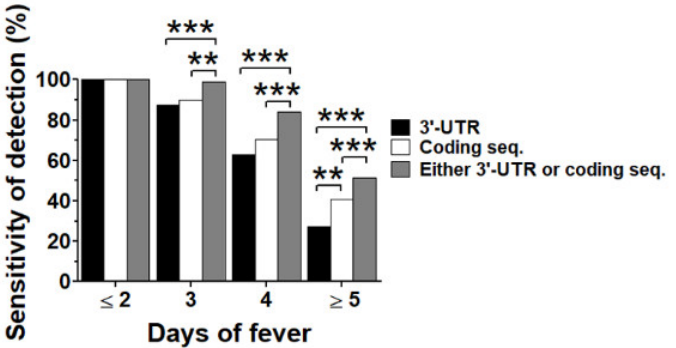
Figure 4. Efficiency of DENV genome detection. Data from Figure 2c were re-analyzed according to “Day to defervescence”. Detection rates of 3′-UTR assay (black bar) or coding sequence assay (white bar) or detected by either assay (gray bar) were analyzed according to “Day to defervescence”. Proportions of DENV detection rates among groups were analyzed by McNemar’s test. Asterisks (** and ***) represent McNemar’s p values < 0.01 and <0.001, respectively.